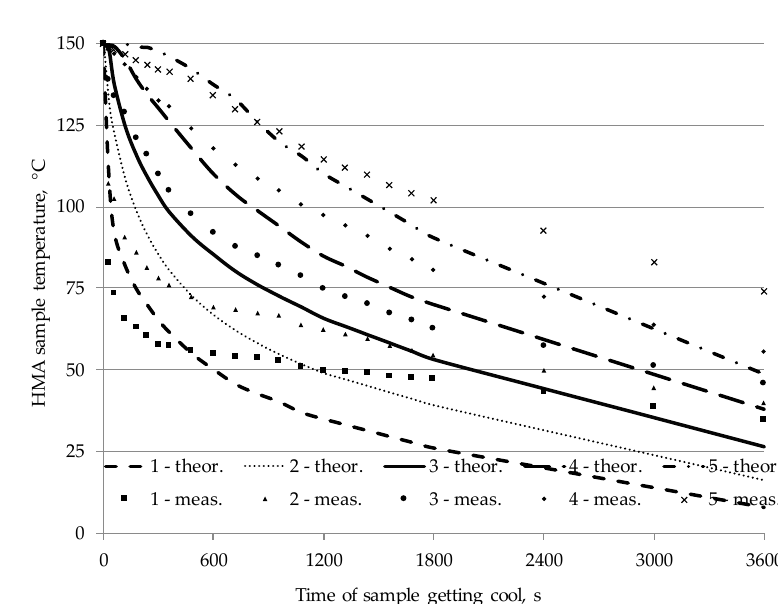
Figure 11. Drops of temperature in the AC 16 W specimen over time at ambient air temperature of 0 ◦ C. Legend: 1, 2, 3, 4, 5—measurement points according to Figure 8, theor.—theoretical temperature obtained from the model, meas.—measured temperature.